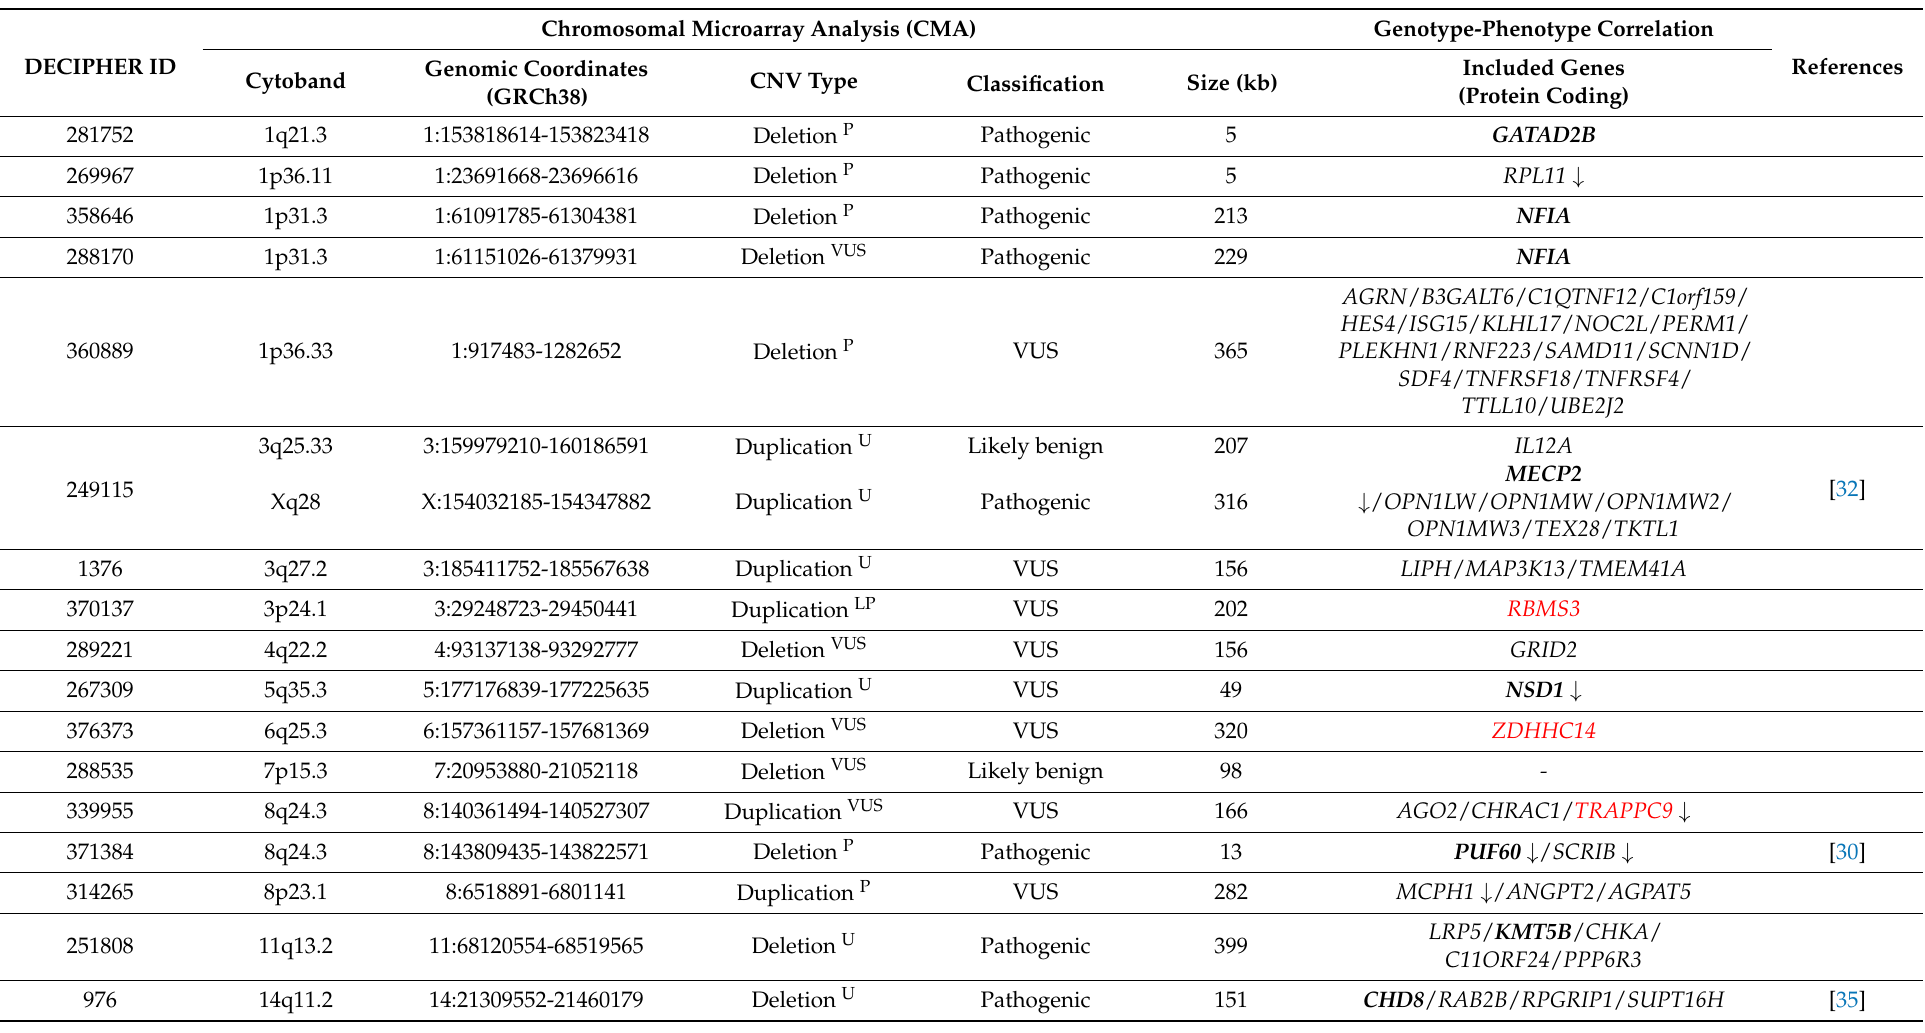
Table 1. Description of the CNV data from the 29 macrocephalic patients with de novo <500 kb CNVs reported in the DECIPHER database and encompassed genes (in bold, known macrocephaly genes; ↓ known microcephaly genes; in red, potential candidate genes for